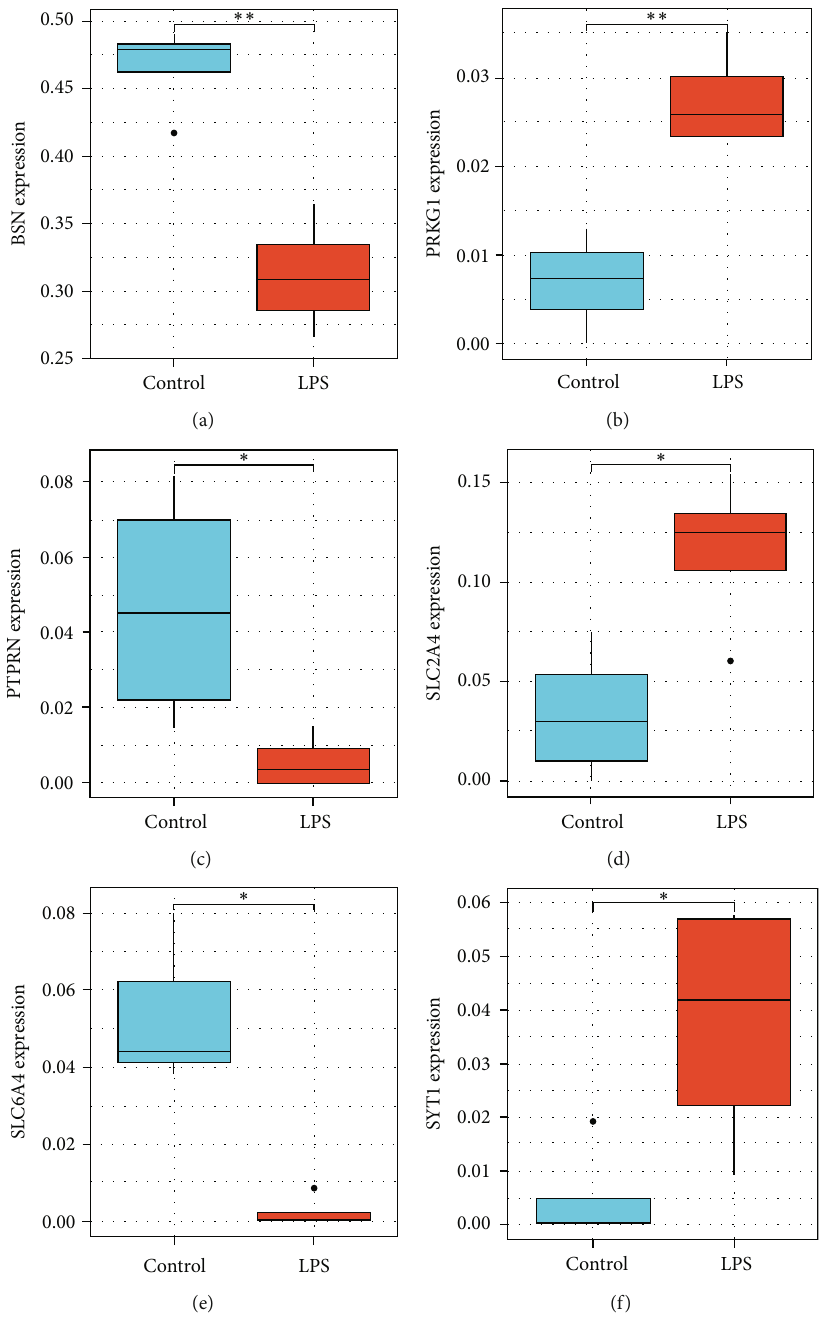
Figure 7: Expression analysis of hub genes. (a – f) The expression level of hub